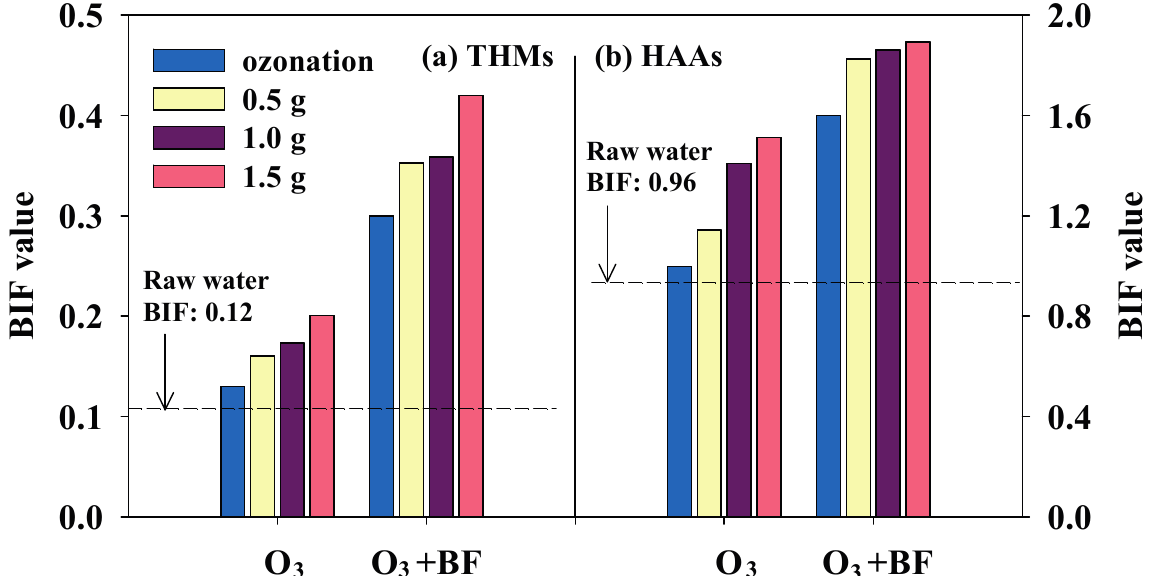
Figure 7. Bromine incorporation factor (BIF) values for ( a ) THMs and ( b ) HAAs for various treatment processes (Raw, raw water; O catalytic ozonation followed by biofiltration; ozone concentration: 2.5 mg·L − 1 ; gas flow: 50 mL·min − 1